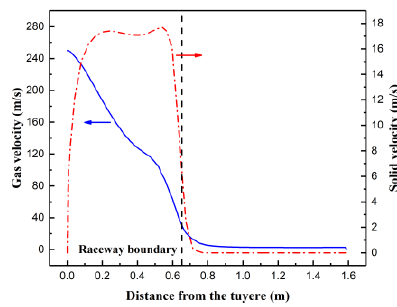
Figure 10. Gas and solid velocity along the axis of the tuyere for Case 3 at 40 s.